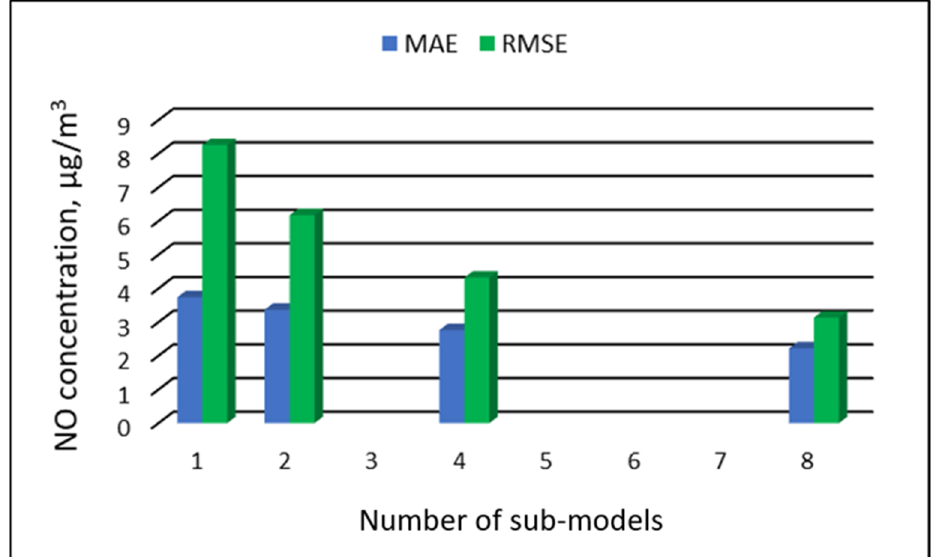
Table 10. Values of approximation errors of NO concentrations in RVS models, Z ł oty Potok 2011– 2016.